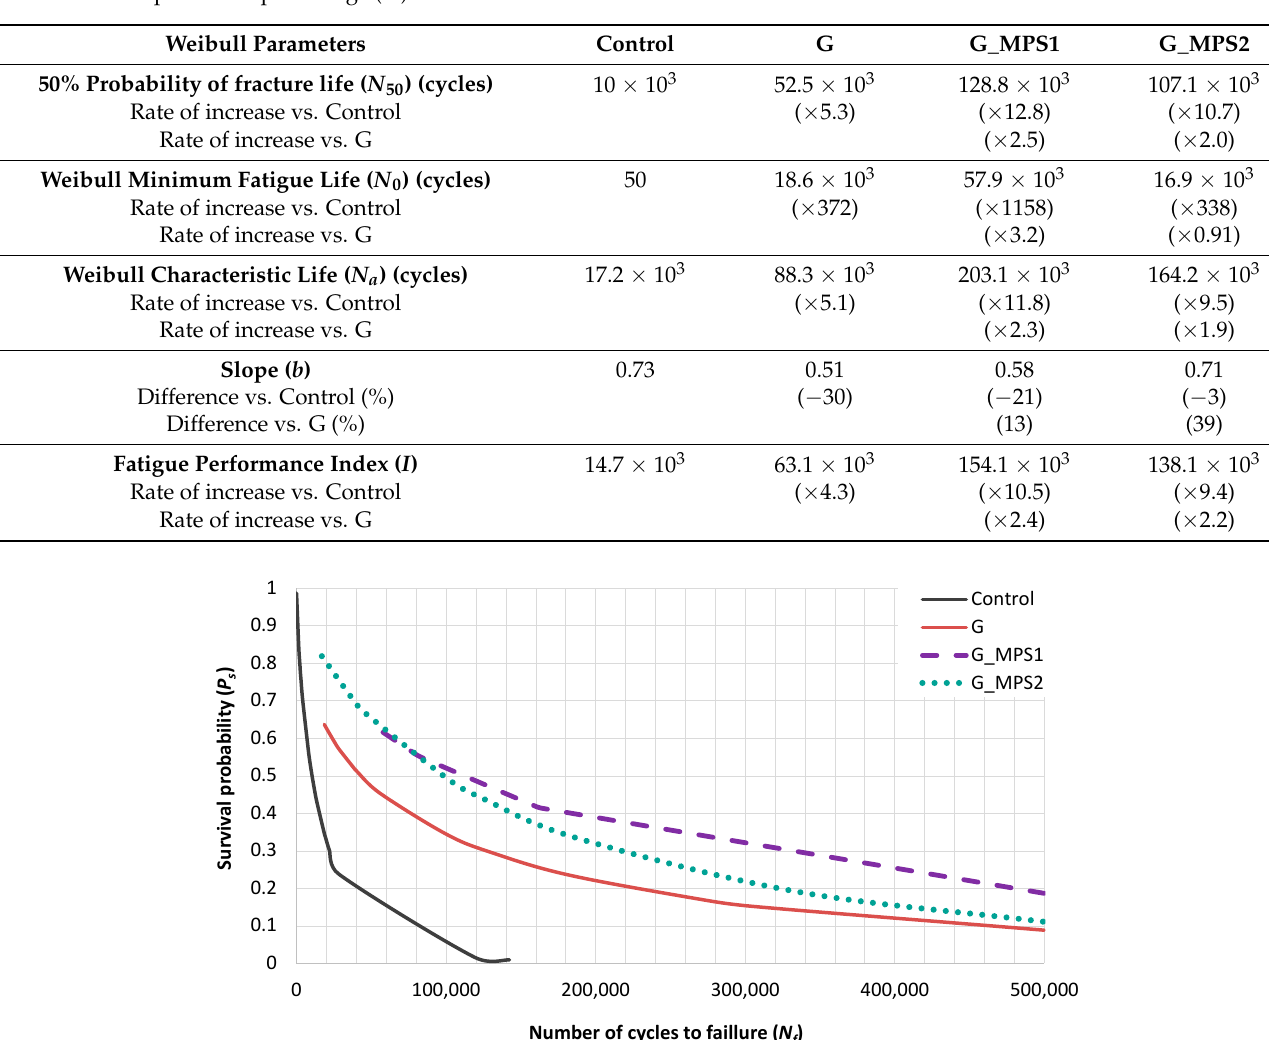
Figure 4. Survival probability vs. the number of cycles to failure for the Control and the cement with 0.1 wt.% of G, G_MPS1 and G_MPS2.